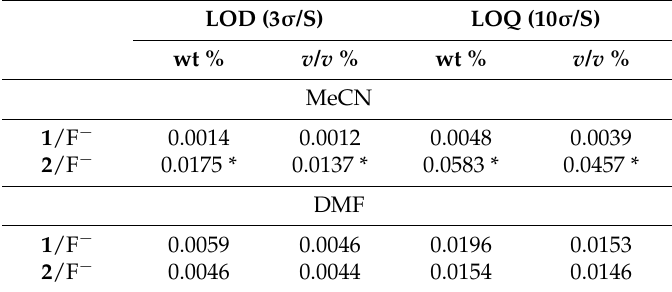
Table 3. Detection limit (LOD) and quantification limit (LOQ) for water in MeCN and DMF using studied two-component coumarin oxime/F − chemosensors (determined by fluorescence spectroscopy; T = 298.16 K).